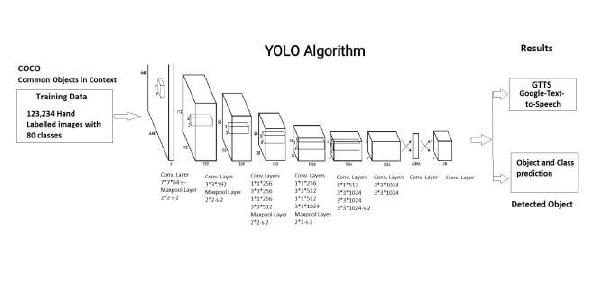
Figure 2. Flowchart depicting the YOLO